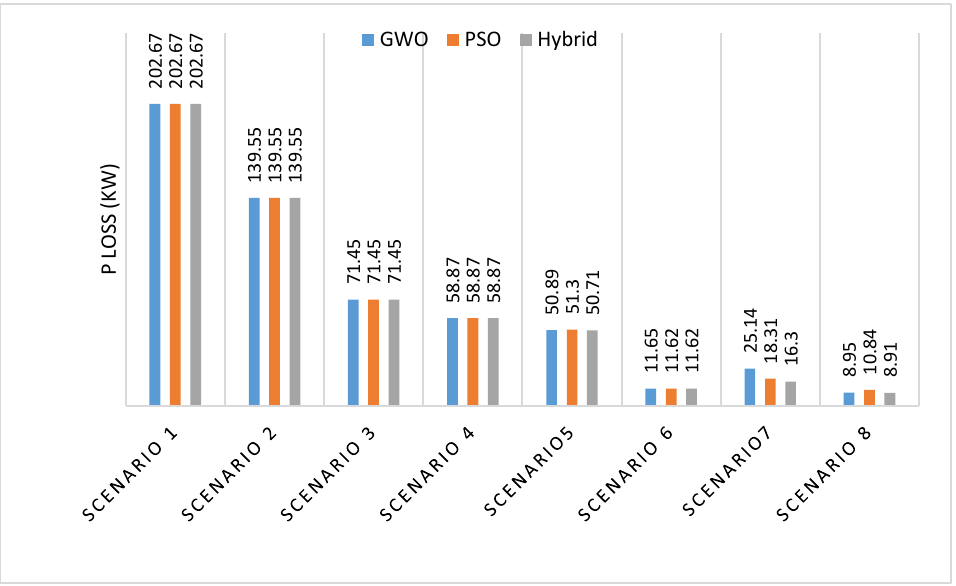
Figure 4. Power loss of a 33-bus system using three different techniques.